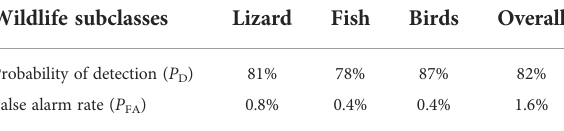
TABLE 2 Wildlife algorithm detection performance for three animal